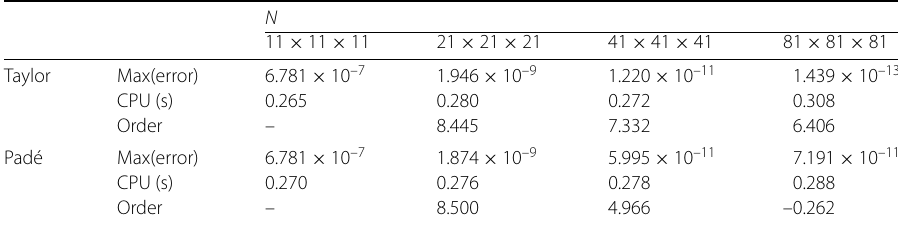
Table 9 Numerical results of three-dimensional parabolic problem at t = 0.1 with x = 0.5 and y = 0.5 for Example